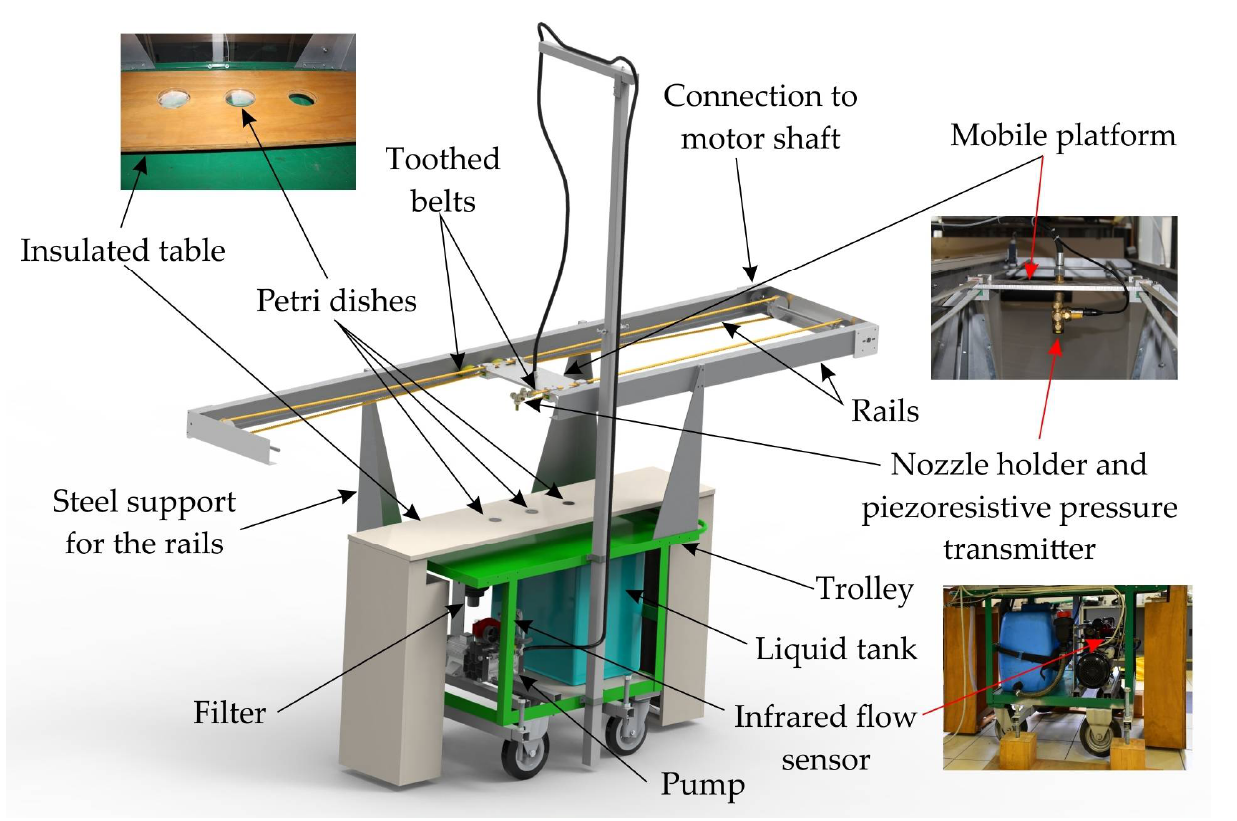
Figure 1. Main components of the test bench.